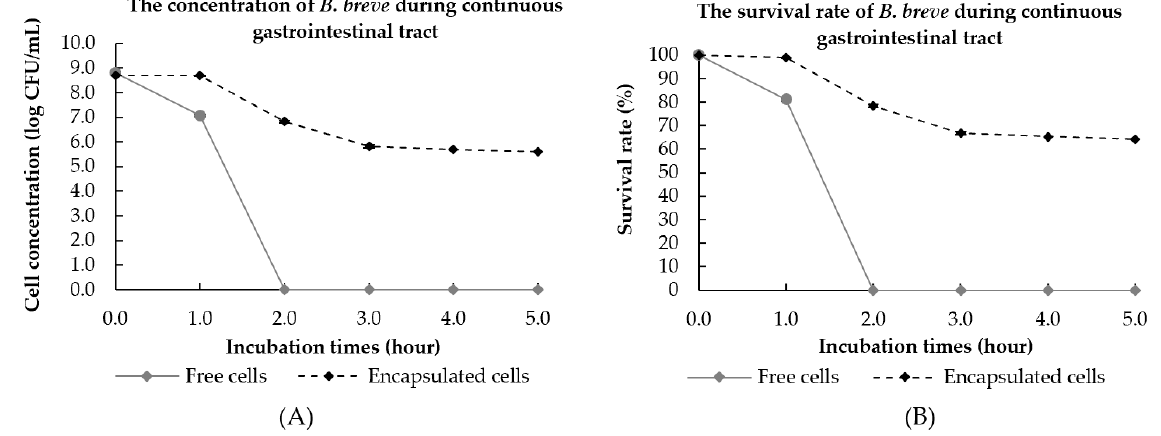
Figure 4. Total viable cell counts (log CFU/mL) ( A ) and survival rates (%) ( B ) of free and encapsu- lated B. breve TISTR 2130 during sequential exposure to simulated gastrointestinal juice (pH 7.5) for 5 h ( n = 3, bars indicate the standard deviation).